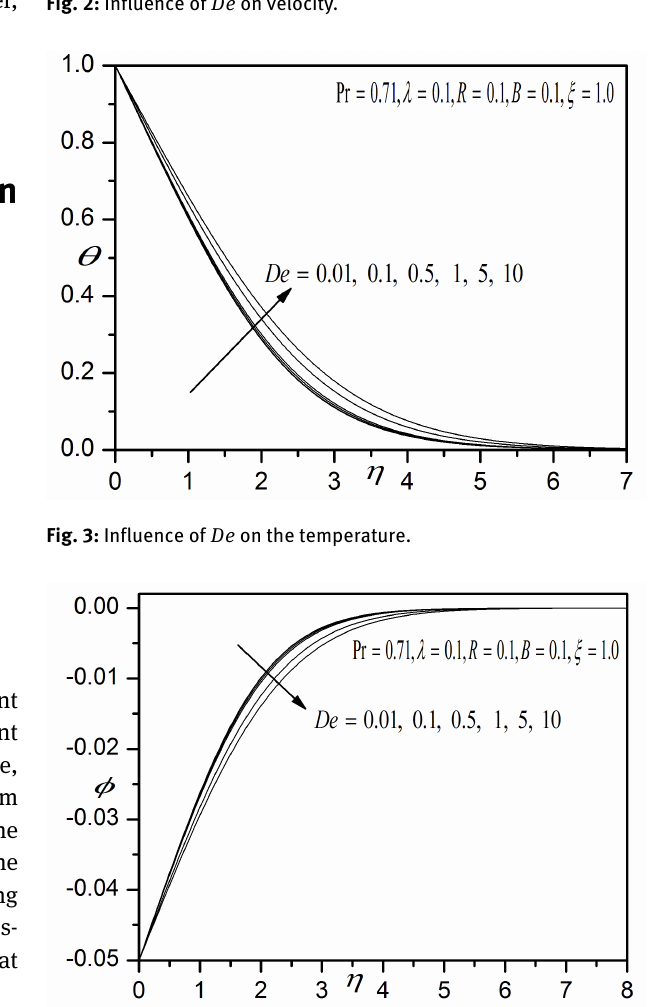
Fig. 2: Influence of De on velocity.